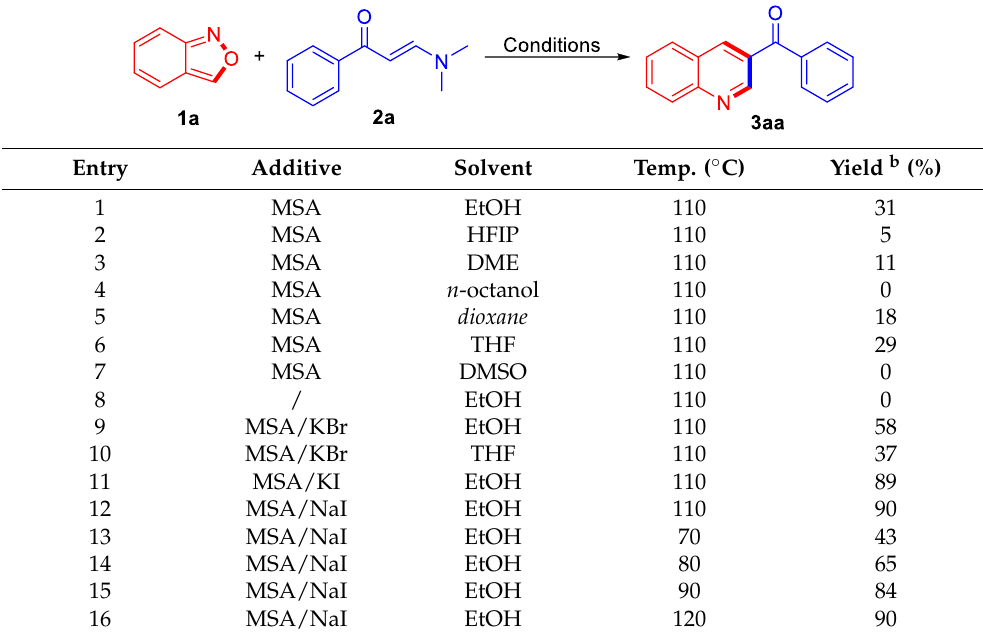
Table 1. Optimization of reaction conditions for the synthesis of 3aa a .